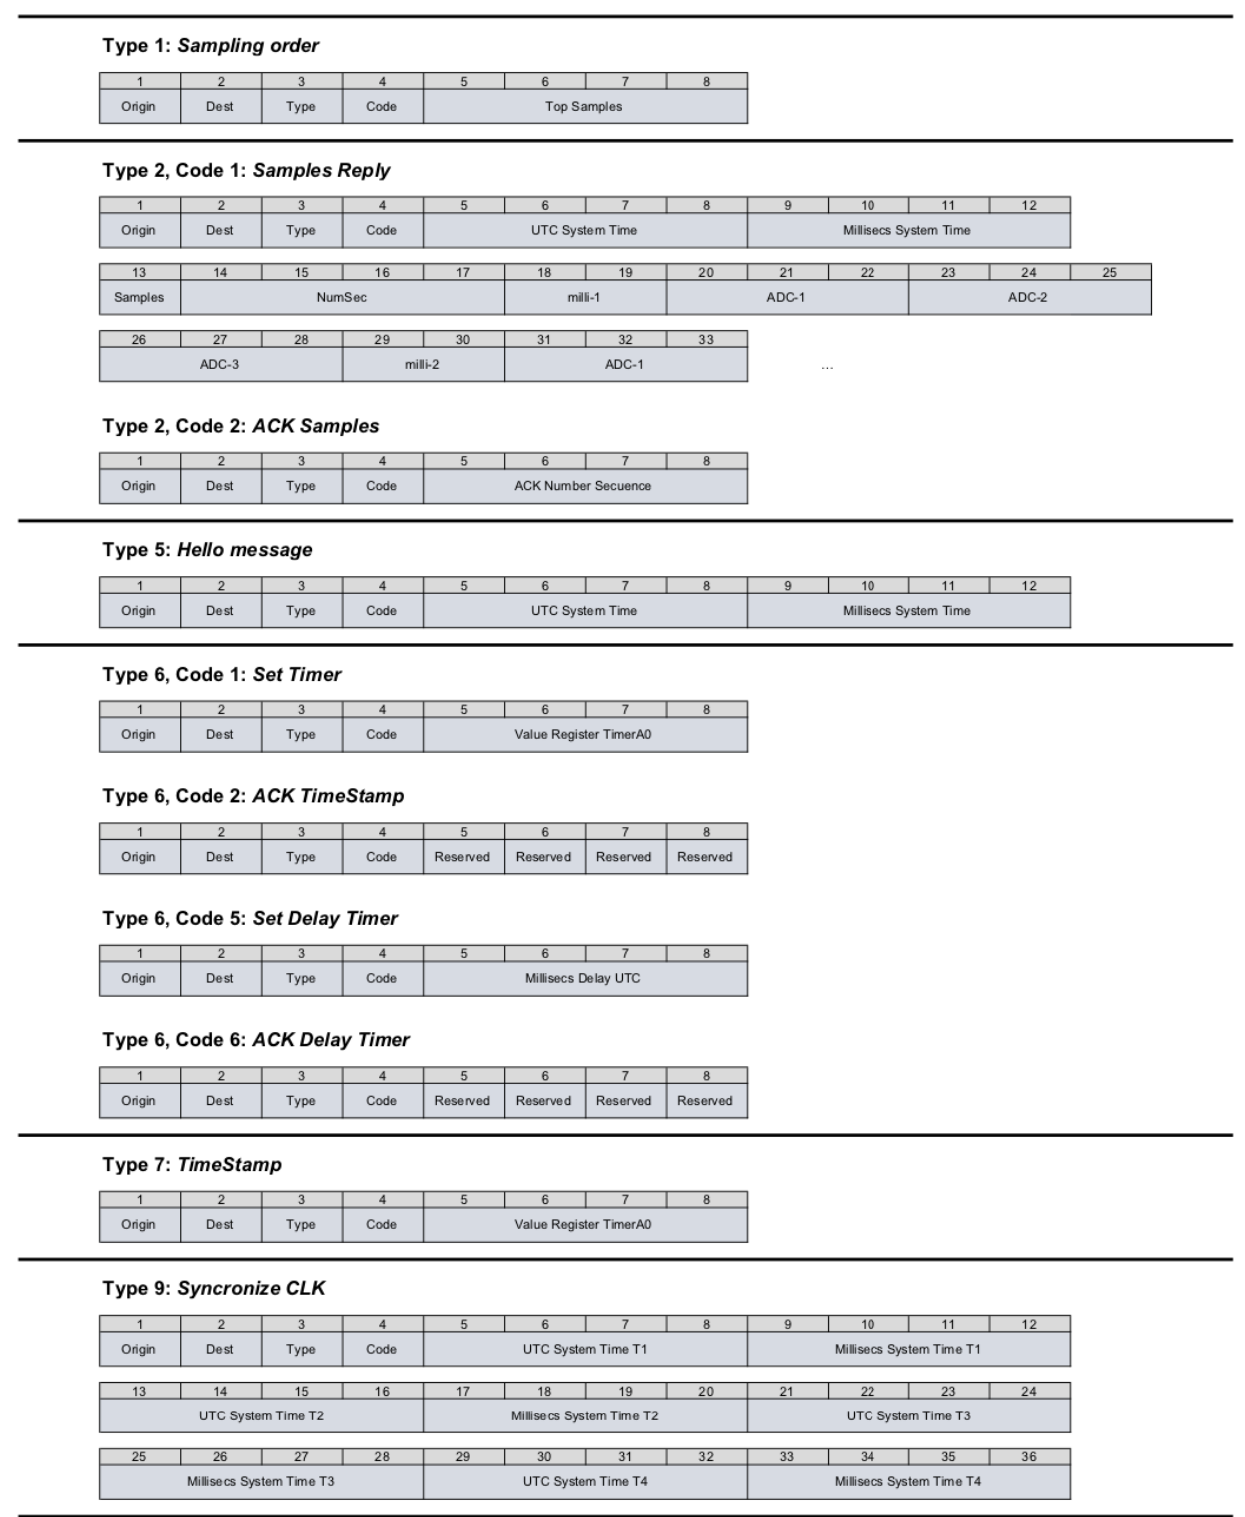
Figure 5. Structure of the messages. Type 6 messages (ST, Set Timer) are related to setting the time and clock of the